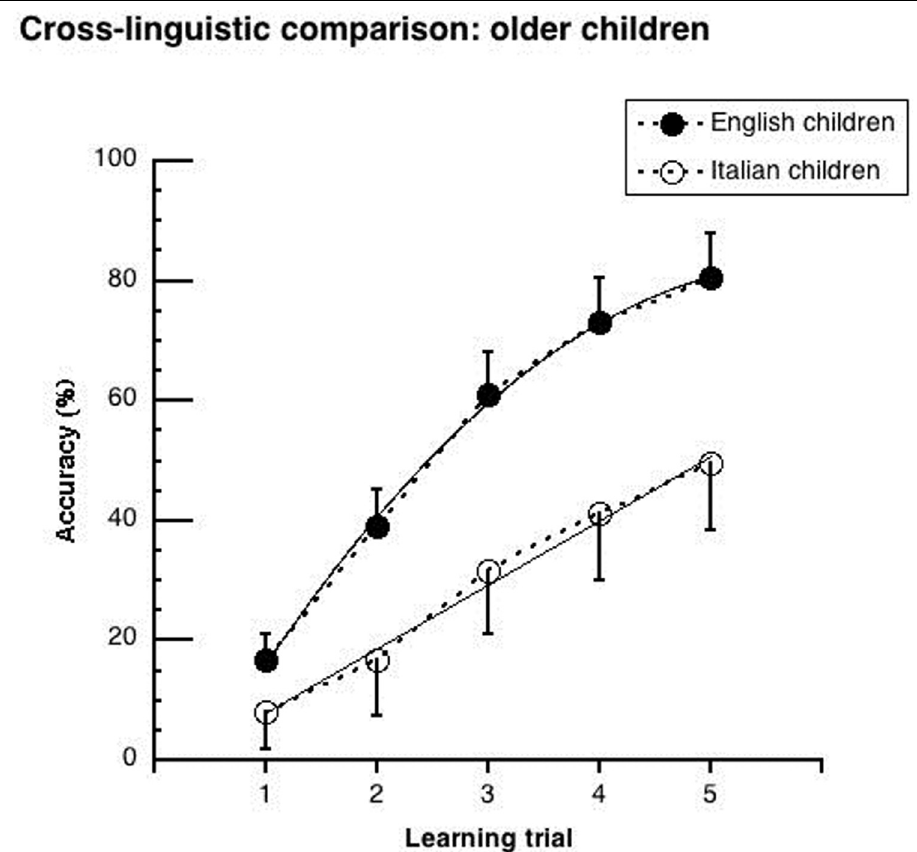
Fig 4. Mean performance (and .05 confidence intervals) of “older” children on the lexical learning task as a function of trial sequence. Data are separately presented for Italian and English participants. Interpolation is based on significant trends. For the Italian children, a linear regression well explains the data (y = 6.95 + 10.67x; r 2 = .99). For English children, performance is well explained by the combination of a linear and a quadratic trend (y = -14.15 + 33.07x -2.82x 2 ; r 2 = .99).